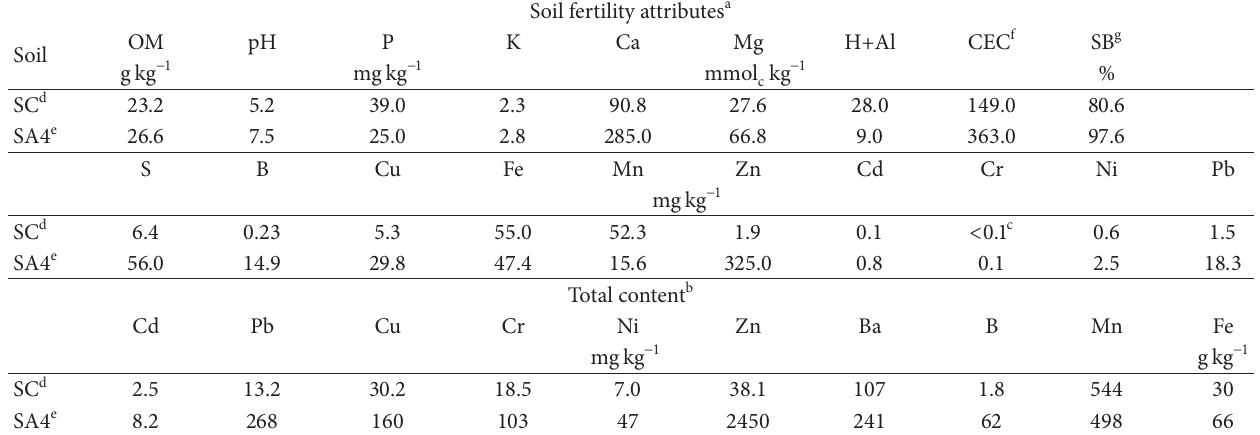
Table 2: Total element content, available content of heavy metals, and fertility evaluation of the original soil samples studied. Soil fertility attributes a OM pH P K Ca Soil